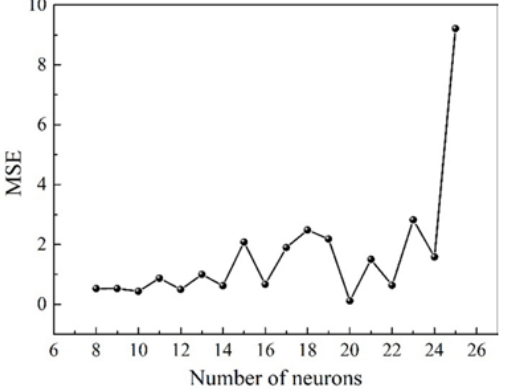
Figure 7. Performance of different numbers of neurons. MSE in the figure represents mean square error. The accuracy of the established ANN model is further verified by a wide variety of standard statistical performance evaluation methods. The generalization property of the training and testing neural network is quantitatively verified in terms of correlation coefficient ( R ), relative error ( δ ), average absolute relative error ( e AARE ), average root mean square error ( e RMSE ), and scatter index ( I S ). The above indexes are defined as listed,